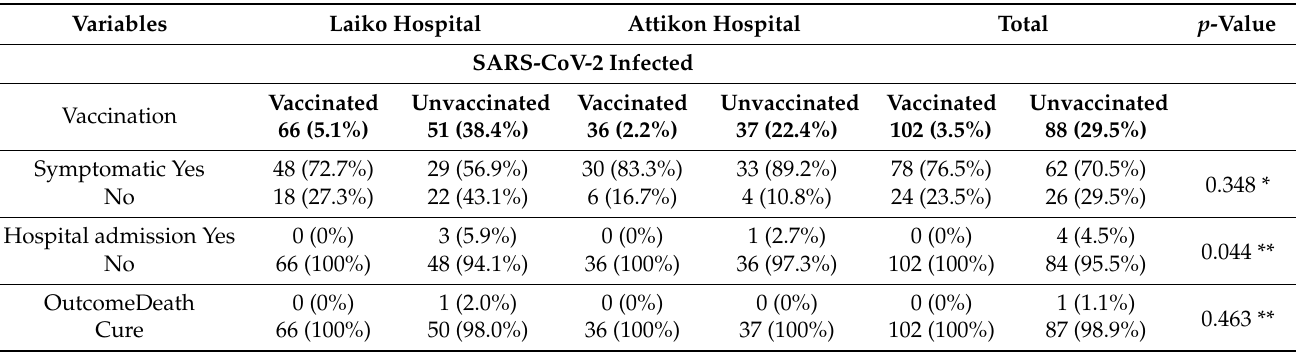
Table 3. Main outcomes among SARS-CoV-2 infected vaccinated and unvaccinated Health-Care- Workers (HCWs) in two Academic Hospitals in Athens, Greece, in terms of infection, hospital admission and death.